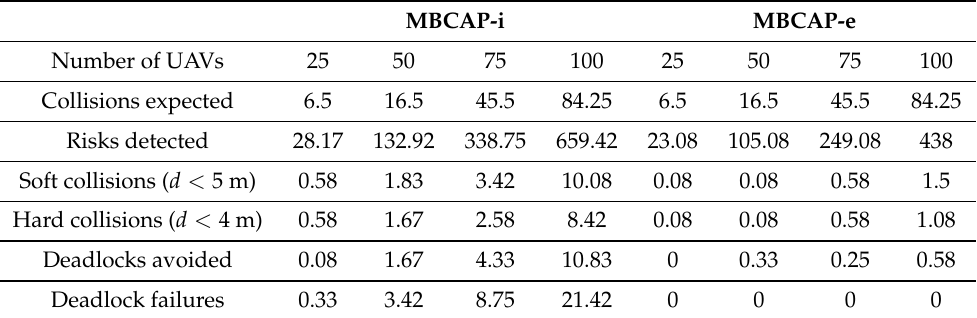
Table 4. MBCAP-i vs. MBCAP-e: Collision avoidance performance (mean value by